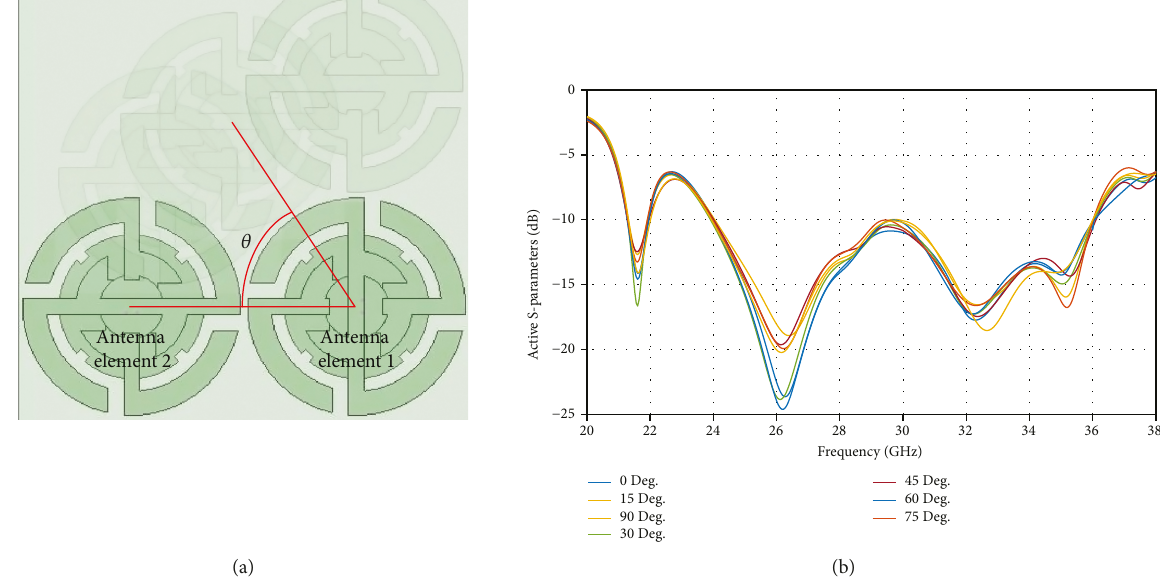
Figure 4: (a) Geometry and (b) simulated active S-parameters of the MIMO antenna with di ff erent angel between two elements.